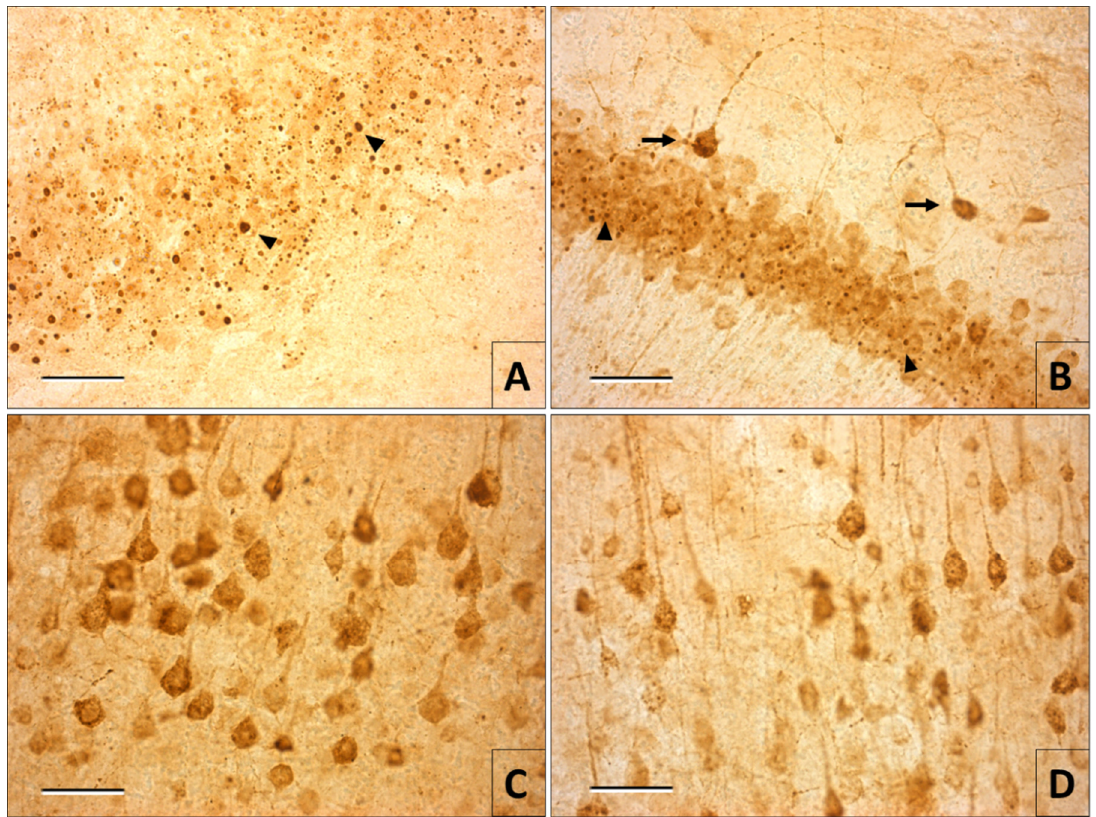
Figure 2. Immunohistochemistry for rabies in 50 µm thick slices from vibratome. ( A ) Perfusion-fixed cerebellum slice from an animal. Note the immunoreactivity of the intracytoplasmic viral inclusions (arrowheads), but there is no cytoplasmic marking that allows us to delimit the cellular morphology. ( B ) Cerebellum with 6 h of postmortem degradation, where several viral inclusions (arrowheads) and morphology delimitation of the Purkinje cells are observed (arrows). ( C ) Neurons of the cerebral cortex at 12 h postmortem. The immunostaining delimits the perikaryon morphology and a short segment of the apical dendrite, but it is hard to identify intracytoplasmic viral inclusions. ( D ) Cortical pyramidal neurons at 30 h postmortem. There is a loss of neurons in some areas due to degradation, but in others, the intense immunoreactivity of the soma and of the apical dendrite is preserved (Magnification A-D 40×) (bars = 50 µm).